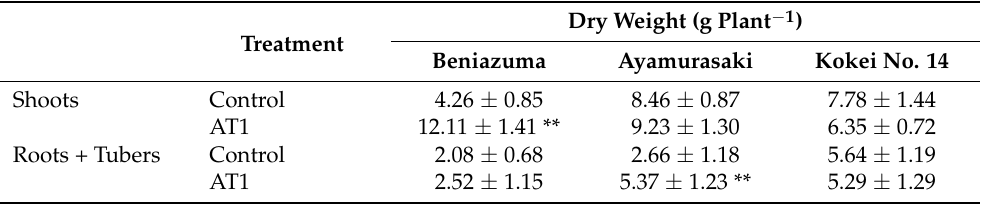
Table 3. Effect of Bradyrhizobium sp. AT1 inoculation on total plant dry weight of three cultivars of sweet potato grown in containers *.